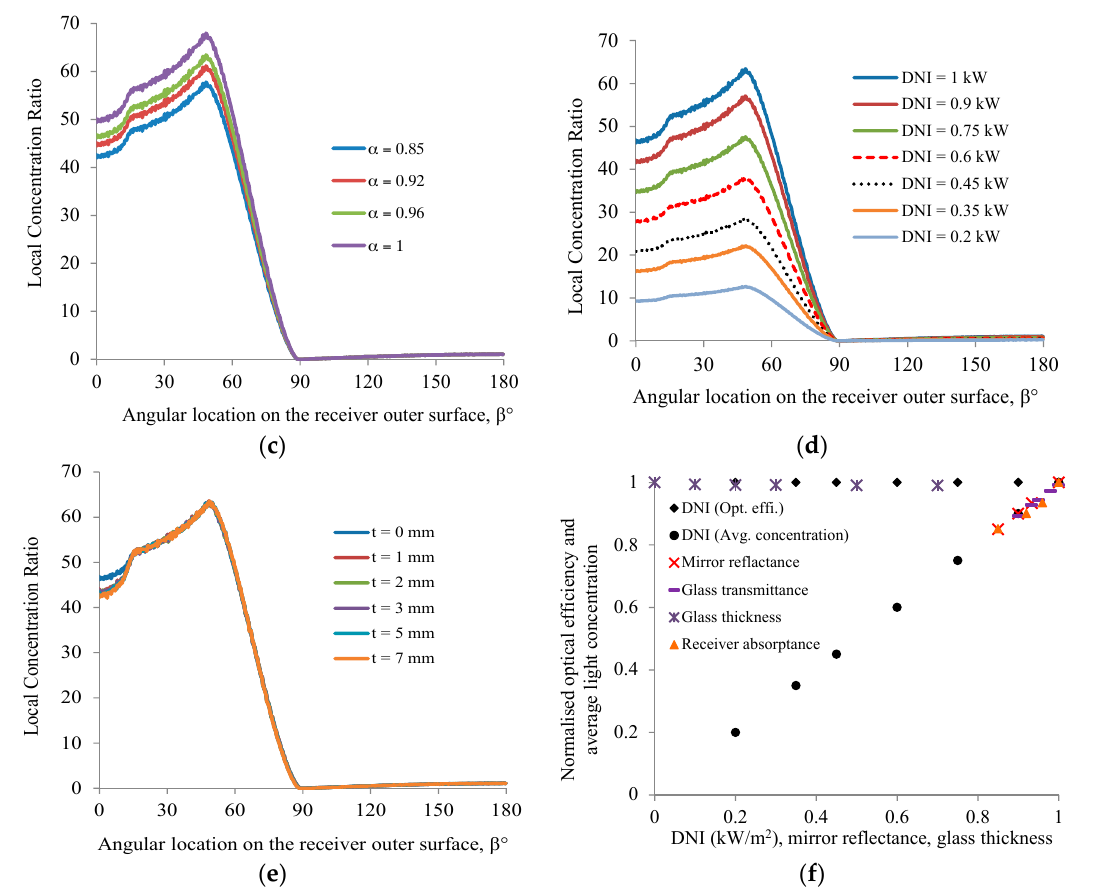
Figure 6. Effect of ( a ) mirror reflectance; ( b ) glass transmittance; ( c ) receiver absorptance; ( d ) DNI and ( e ) glass thickness on the LCR distribution around the receiver tube, and ( f ) effect of these parameters on the normalised optical efficiency, η opt , and normalised average light concentration, C avg , of the collector. (These values were normalised dividing by their respective maxumum value).